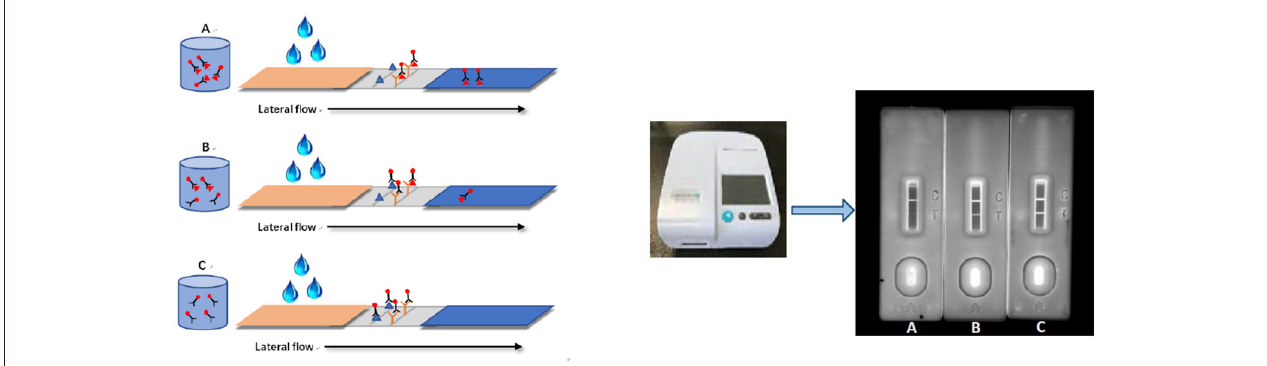
FIGURE 1 | Schematic illustration of QDs-ICS for qualitative detection of acetamiprid. Panels (A,B) are the results of positive samples which are spiked with 10 and 1ng/mL acetamiprid. Panel (C) is the result of negative sample.